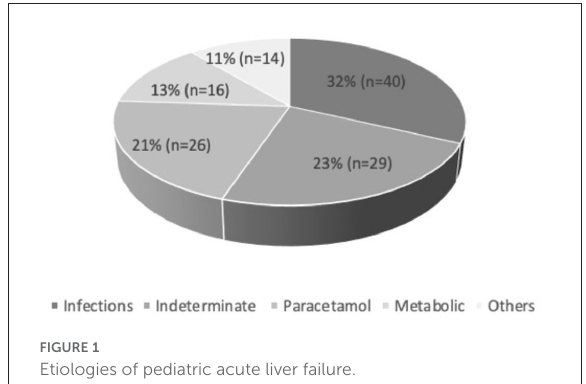
FIGURE1 Etiologies of pediatric acute liver